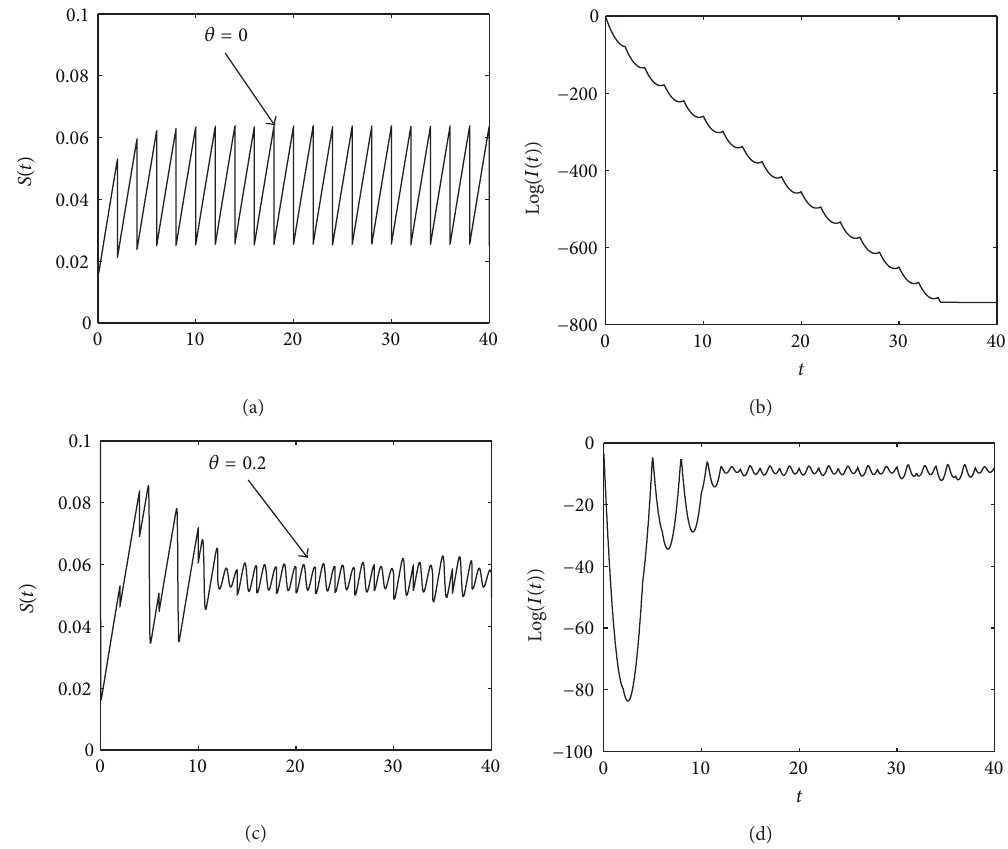
Figure 2: The effects of resource limitation on dynamics of model (4) with 𝑝 max = 0.5 , 𝑇 = 2 , and all other parameter values are given in Table 1. (a and b) 𝜃 = 0 ; (c and d) 𝜃 = 0.2